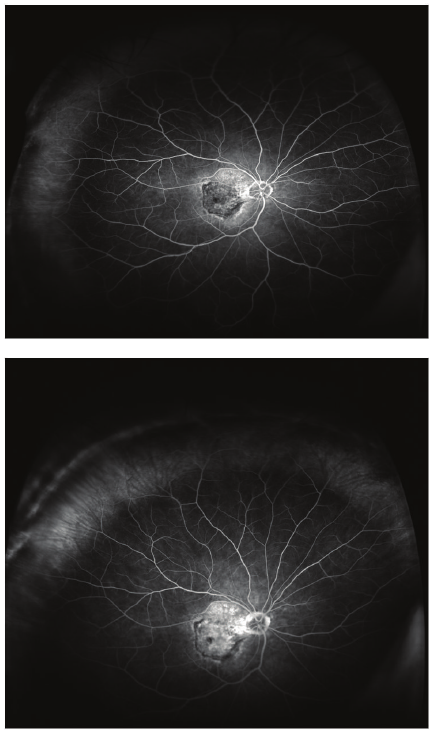
Figure 4: Diffuse leakage and hyperfluorescence in zone 3 (100– 200 ∘ ) in an eye with active fibrovascular pigment epithelial detach-